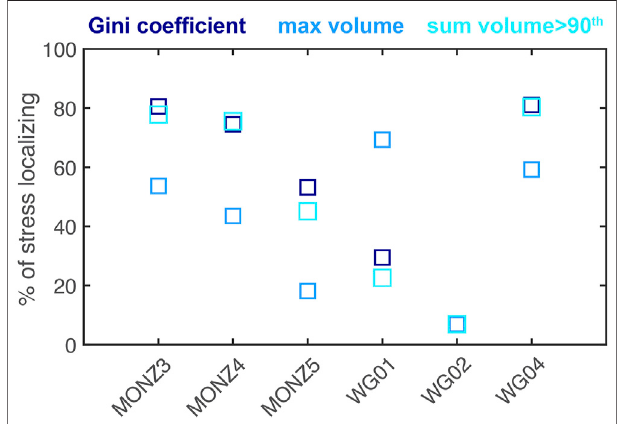
FIGURE7| Percentageoftheapplied differentialstressinwhichtheGini coef fi cient, v max /v tot , and (cid:1) v 90 / v tot show localization, i.e., increase from one scan to the